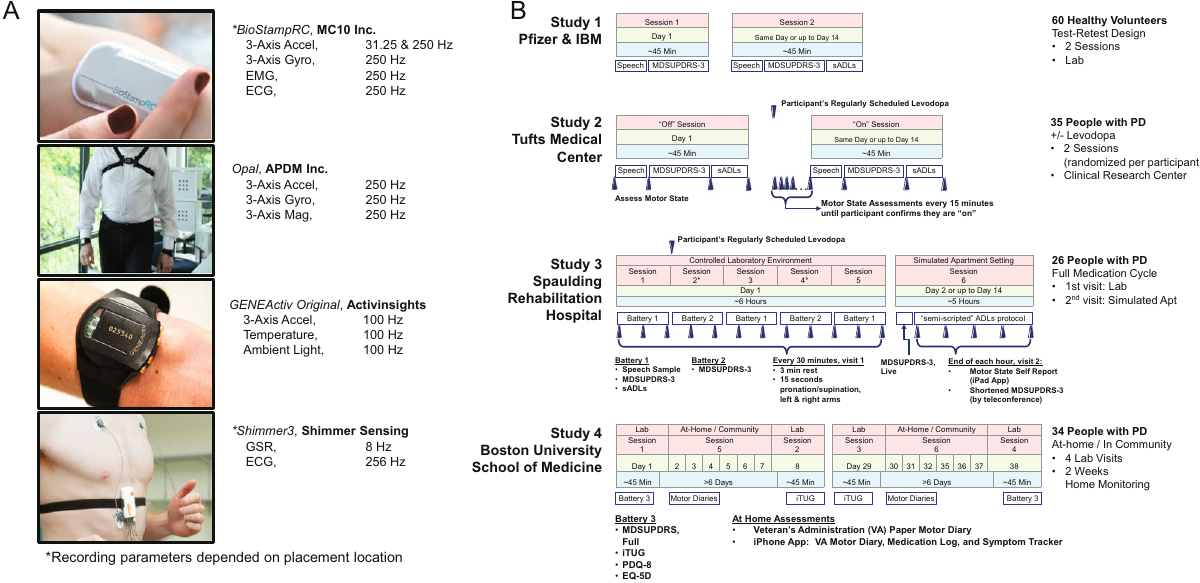
Fig. 1 Devices and study designs. a Wearable devices and recording parameters that were utilized throughout the project. b In studies 1, 2, and 3, multiple administrations of the MDS-UPDRS part III, scripted activities of daily living (sADL ’ s), and speech tasks were performed. For participants with PD, sessions were timed to take place around PD participants ’ regularly scheduled dose of levodopa, and we obtained both a live rating and three video ratings (from separate raters) of the MDS-UPDRS part III for each session. In addition, participants with PD self- reported their motor state multiple times throughout the laboratory sessions. Video raters were blinded to when the participant had taken their medications. In study 4, participants with PD completed 2 weeks of at-home monitoring with the ultimate goal of investigating the relationship between continuous estimates of motor state derived from wearable sensor data, participants ’ self-report of their motor state, and the timing of levodopa. BioStampRC image used with permission from MC10. GENEActiv original image used with permission from